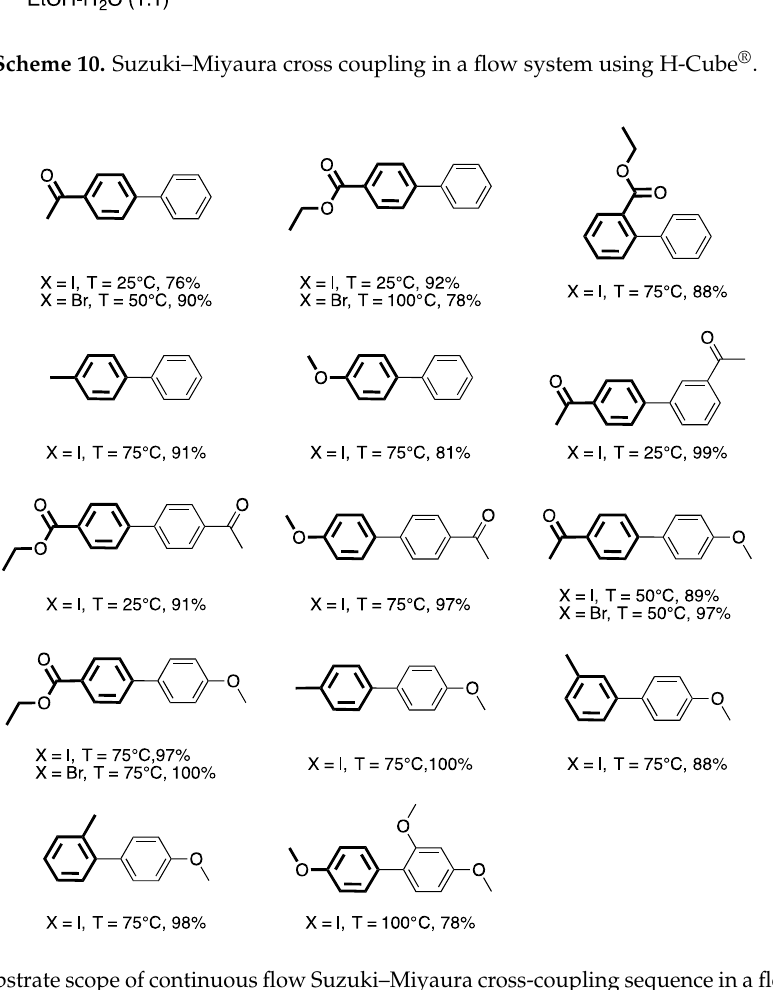
Figure 2. Substrate scope of continuous flow diazotization/iododediazotization/Suzuki–Miyaura cross-coupling sequence starting from aniline derivative.